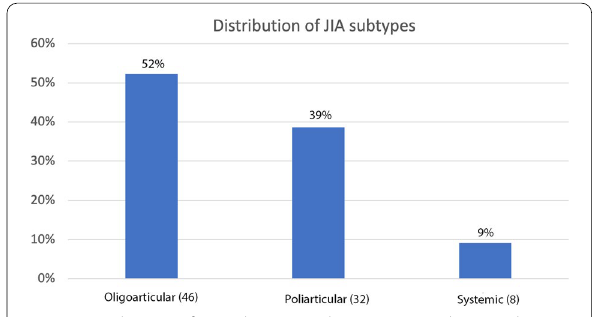
Fig. 1 Distribution of JIA subtypes in the present study according to ILAR